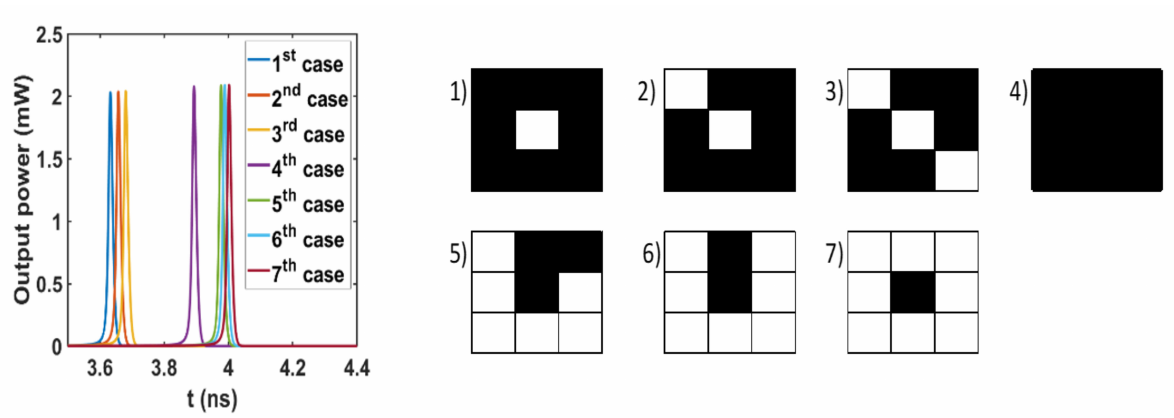
Figure 4. Output power of the CDL for different input cases. Black boxes represent black pixels of the scanning window (SW) (no light input) while white boxes represent white pixels of the image (presence of light). While C-neurons receive input the latency is decreased. However, the activation of S-neurons augments the latency. On the contrary, when all S-neurons receive light but C-neurons do not, the latency is increased, while the activation of fewer S-neurons accelerates the produced